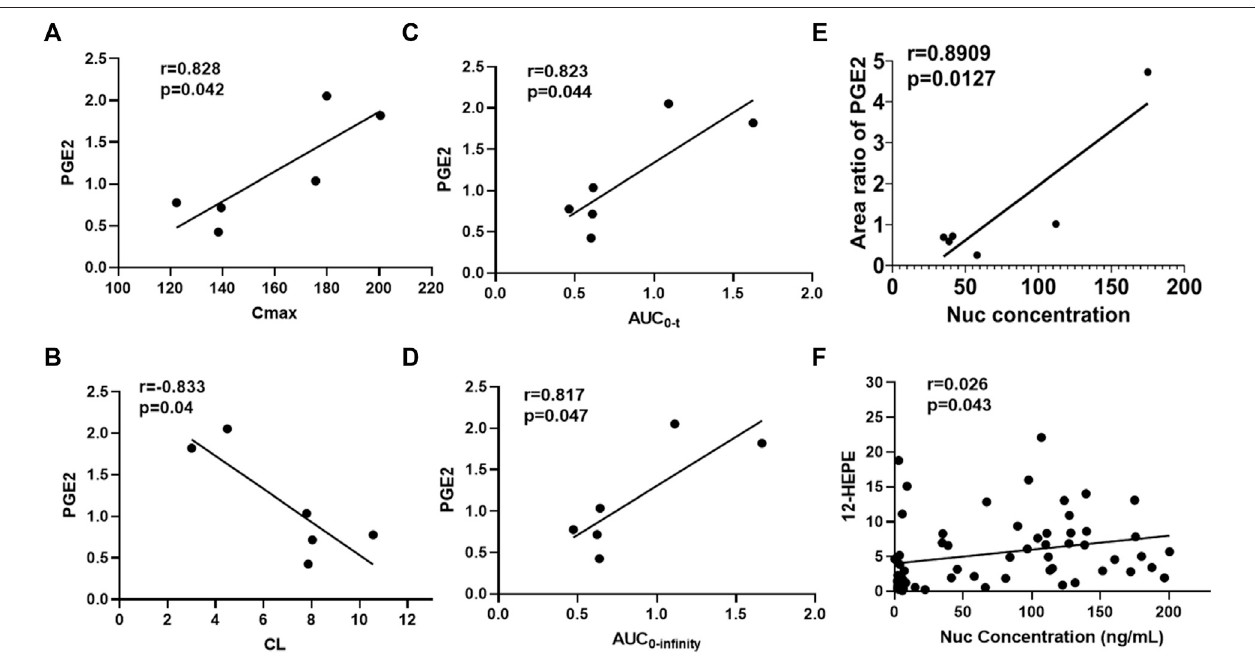
FIGURE 5 | Correlation analysis between metabolites and pharmacokinetic parameters of Nuc. (A) Area ratio of PGE2 vs. C max ; (B) Area ratio of PGE2 vs. CL; (C) ArearatioofPGE2 vs. AUC